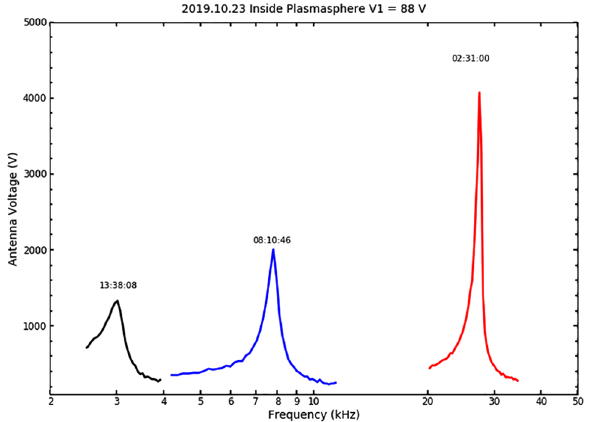
Figure 4. An example of resonance curves, antenna voltage of Y+ branch, V 1+ as functions of frequency, from high-power transmission ( V 1± = 88 V) in a nominal plasmasphere determined by the Carpenter-Anderson empirical plasmaspheric model 34 . The transmission started in the higher frequency band and then went to mid and lower bands. The universal time when these voltage curves were acquired is indicated above each